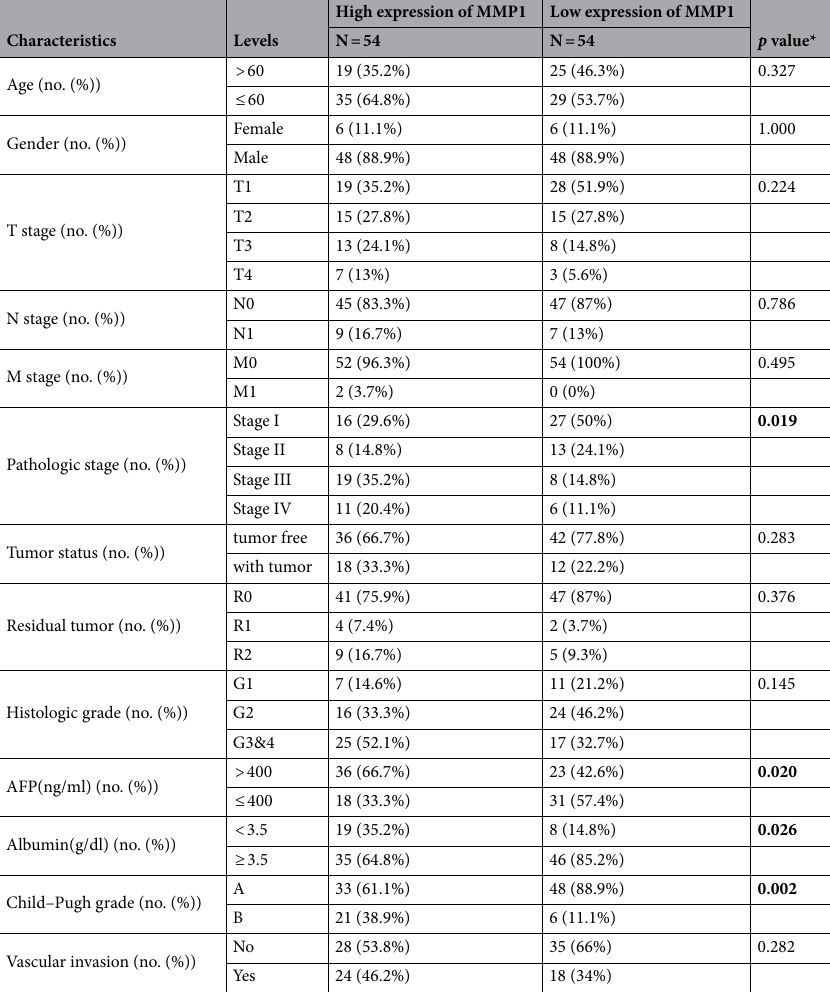
Table 7. Baseline characteristics of patients (Clinic HCC). Data are presented as n (%). *Compared with each group (Fisher exact test, or Pearson’s chi-square test). p value < 0.05 was considered statistically significant (highlighted in